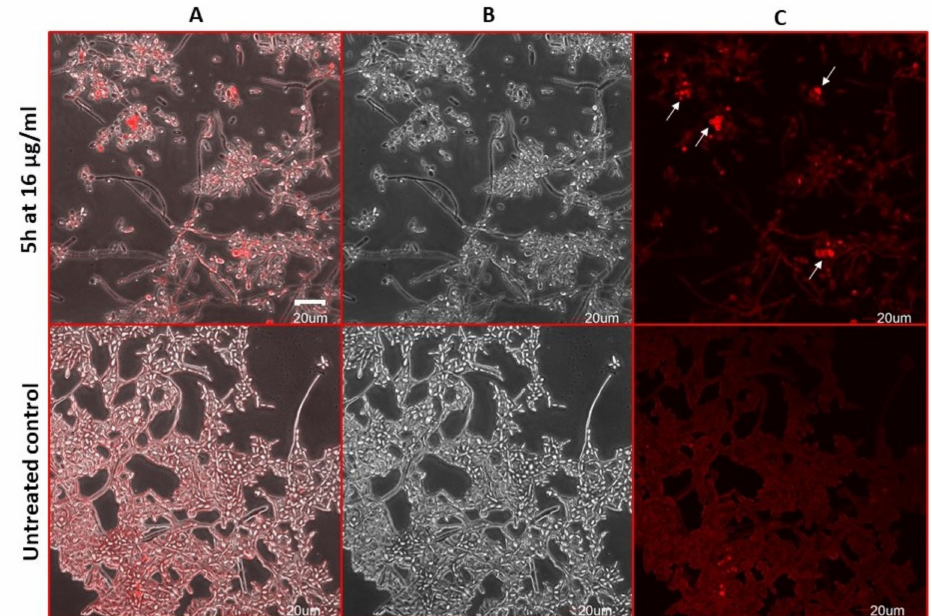
Figure 7. Congo red (CR)-stained C. albicans SPZ176 sessile growth. Legend: Confocal laser scanning microscope (CLSM) analyses: ( A ) phase contrast and fluorescence merged; ( B ) phase contrast and ( C ) fluorescence images. ( A – C ) Upper raw depicts elevated beta -glucan CR-stained (arrows) in several cells in the conglomerate of sessile growth treated with 5h at 16 µ g/mL. Lower raw included the untreated controls showing lack of CR